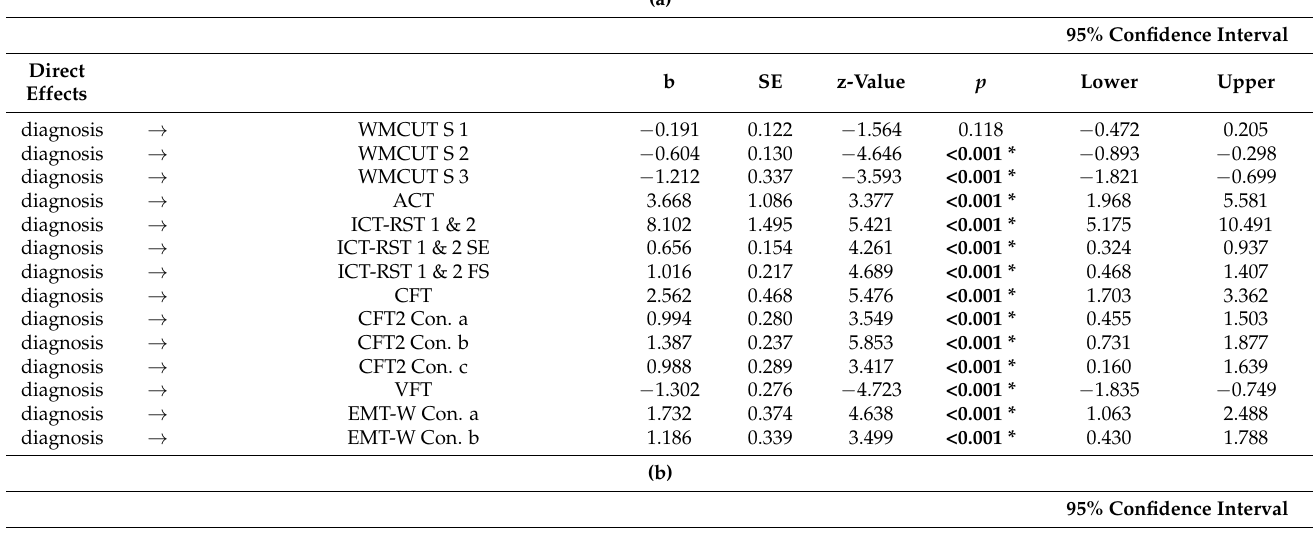
Table 4. ( a ) Direct effects of diagnosis on the R4Alz-R tasks and subtasks’ performance according to Mediation Analysis, between the groups of HC and MCI (* p < 0.004). ( b ) Indirect effects of diagnosis—via age and education—on the R4Alz-R tasks’ and subtasks’ performance according to Mediation Analysis, between the groups of SCD and MCI (* p <